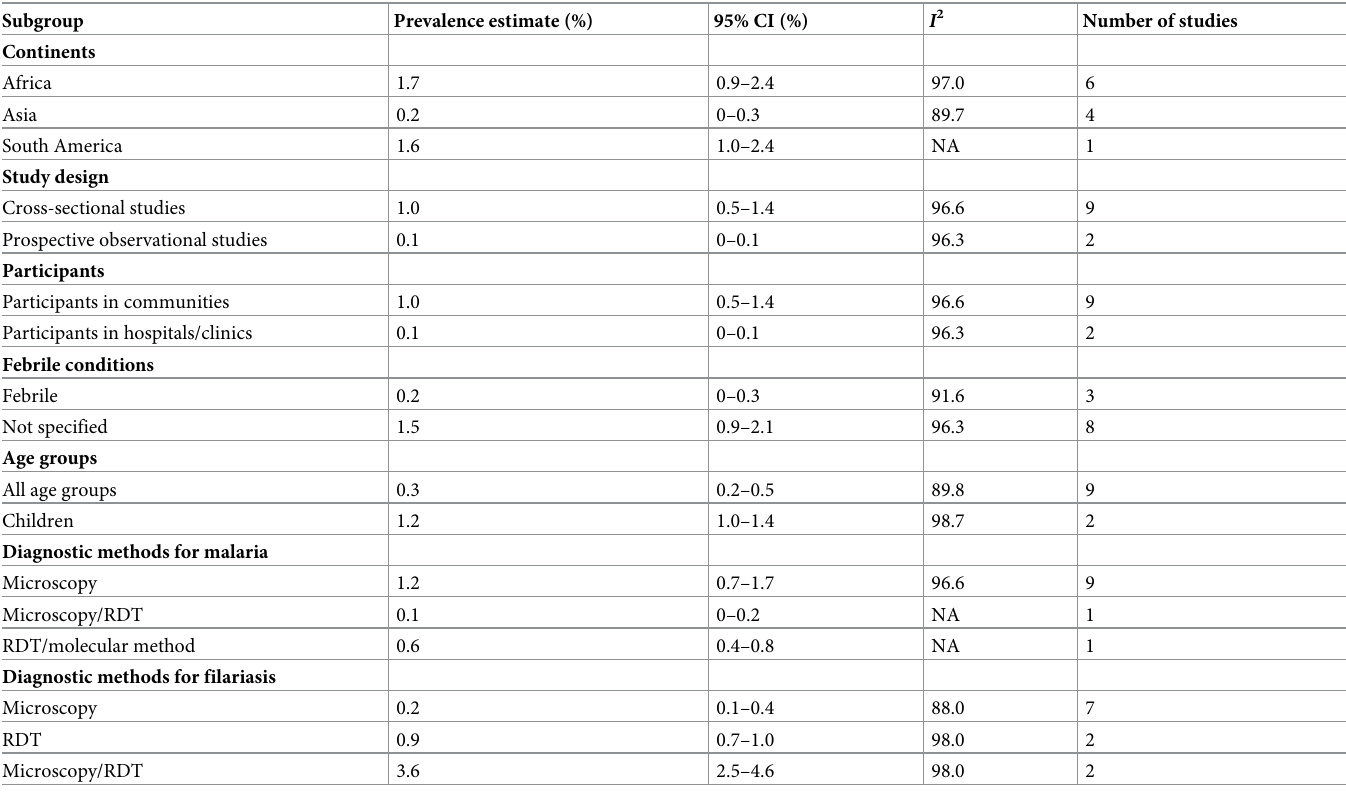
Table 3. Subgroup analyses of the prevalence of malaria and Wuchereria bancrofti co-infections among selected